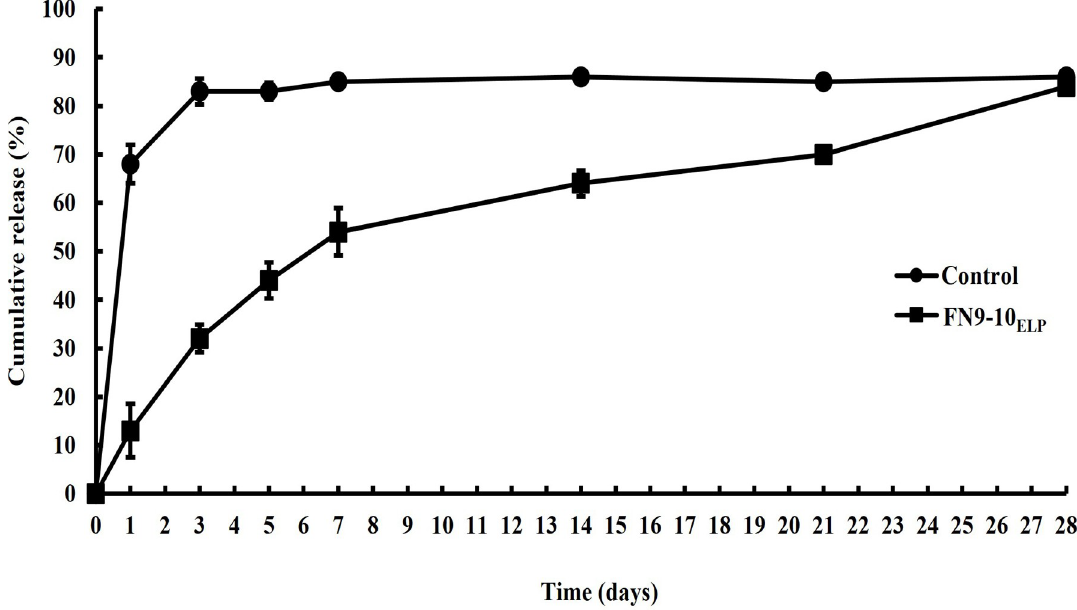
Fig 3. In vitro cumulative release profiles of FN9-10 ELP from titanium discs. The titanium discs were coated with FN9-10 ELP (10 μ g � mL − 1 ) and a control substance (5% BSA) in a volume of 500 μ L/disc overnight at 4˚C. The amount of FN9-10 ELP absorbed from titanium discs was measured using an ELISA. The cumulative release was evaluated as the initial attachment amount (100%). The Release profiles indicate the mean ± SD (n =